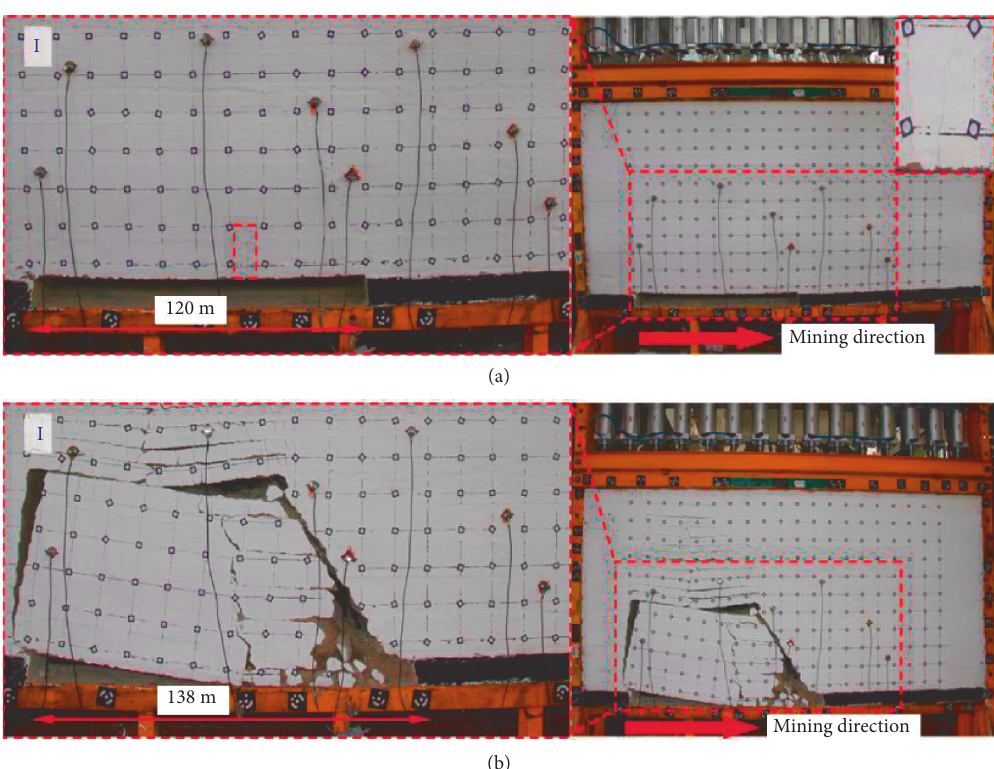
Figure 3: Instability migration rules of overlying strata in mining. (a) The working face advanced to 120m. (b) The working face advanced to